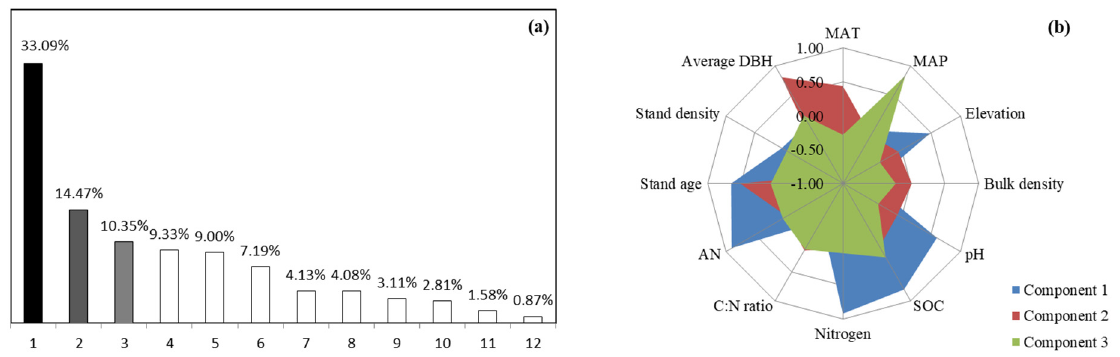
Figure 3. Scores of the principal components analysis (PCA) for soil microbial functional diversity on the correlation matrix of soil physico-chemical characteristics, climatic conditions, and vegetation data ( a ), and the principal factors contributing to distinction between soil samples ( b ). MAT, mean annual temperature; MAP, mean annual precipitation; SOC, soil organic carbon; Nitrogen, total nitrogen; AN, available nitrogen; Stand age, average stand age; Stand density, average stand density; Average DBH, average stand DBH.